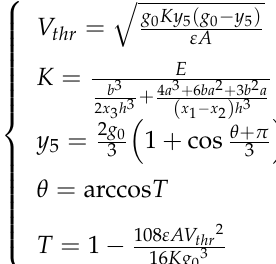
Table 1. Main geometric parameters and specifications of micro-switch. Component Material Geometric Parameter Value ( µ m)